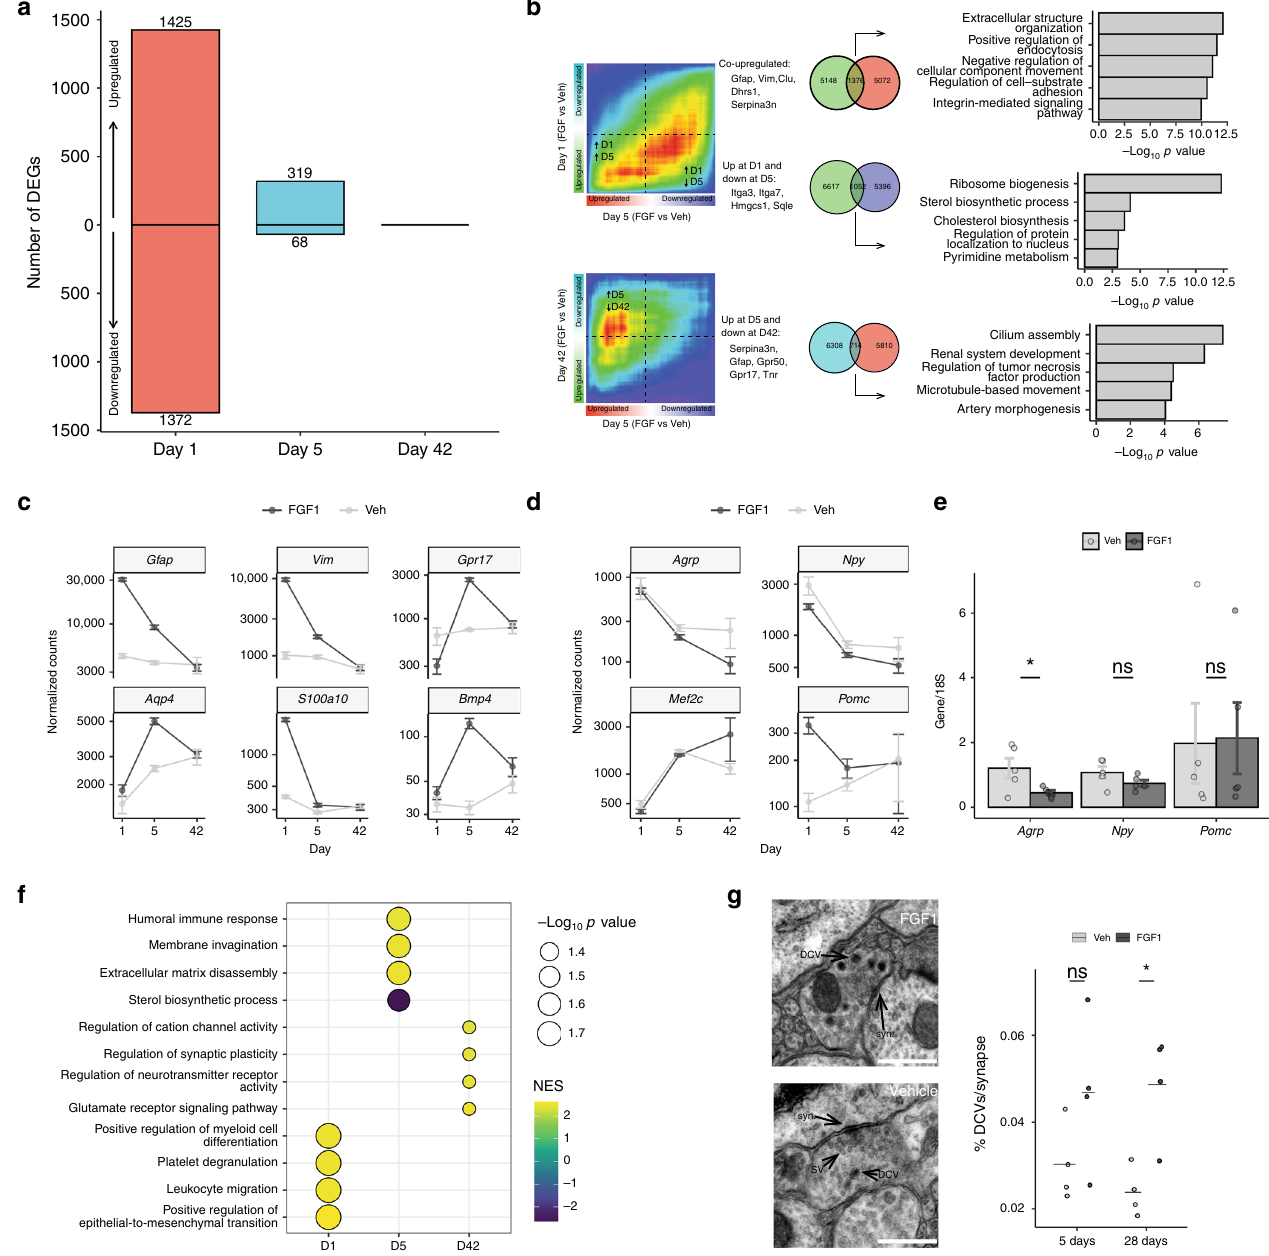
Fig. 7 FGF1-induced long-term changes in the hypothalamus. a Number of DEGs (|log 2 fold change| > 0.5; FDR < 0.05) from bulk RNA-sequencing (bRNA-seq) of hypothalami from Lep ob/ob mice injected with icv FGF1 or vehicle and harvested Days 1 (FGF1 n = 10, vehicle n = 4), 5 (FGF1 n = 9, vehicle n = 7), and 42 ( n = 5 mice/group) after injection. Control vehicle mice were pair-fed to FGF1-injected mice. b Rank – rank hypergeometric overlap maps of the degree of overlapping genes between Day 1 and Day 5 (top) and between Day 5 and Day 42 (bottom). Venn diagrams and top overlapping genes (middle panel). Enrichment of Gene Ontology biological process terms of overlapping genes (right panel). c Normalized counts (mean ± SEM, n = 5 mice/ group) of the selected glial genes from the bRNA-seq datasets Days 1, 5, and 42 after icv FGF1 or vehicle injection. d Normalized counts (mean ± SEM, n = 5 mice/group) of Agrp , Npy , Mef2c , and Pomc expression Days 1, 5, and 42 after icv FGF1 or vehicle injection. e Targeted relative gene expression of Agrp , Npy , and Pomc . Unpaired t test, two tailed, * p = 0.04 (not adjusted, n = 5 mice/group); ns not signi fi cant. Source data are provided as a Source data fi le. f Threshold-free geneset enrichment analysis (Gene Ontology biological processes terms) of DEGs identi fi ed in bRNA-seq data at Days 1, 5, and 42. Point size is scaled by − log 10 ( p value) (Bonferroni adjusted) and is colored based on the normalized enrichment score (NES). g Representative electron microscopic images of synapses of Lep ob/ob mice 5 days after icv injection of either vehicle or FGF1. syn synaptic active zone, DCV dense-core vesicle, SV small light-core vesicle. Scale bar 500 nm. Quanti fi cation: dots represent mean %DCV/synapse per mouse (25 synapses per animal, n = 4/group). Unpaired t test, two tailed, * p = 0.01 (not adjusted); ns not signi fi cant. Source data are provided as a Source data fi le. Data are presented as mean ±